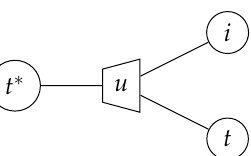
Figure 10. Information bottleneck graph for the alignment of the translation tables of a polar code. The decision level cluster indices t i = [ t , i ] T are clustered into aligned indices t ∗ such that the relevant information I ( U ; T ∗ ) is maximized.